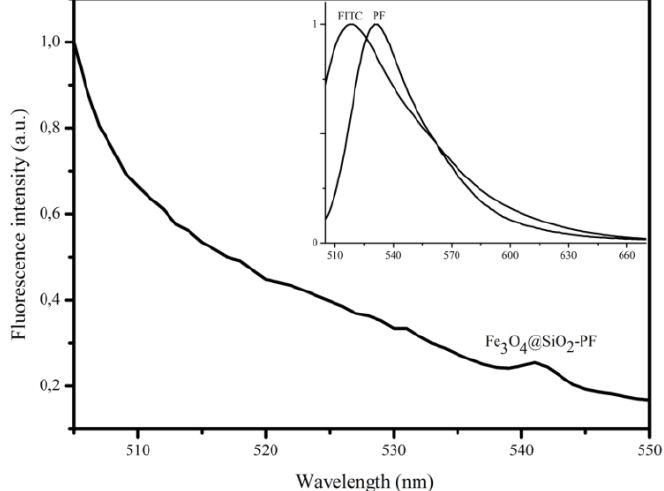
Figure 7. Normalized fluorescence spectra of FITC, PEI conjugated with FITC (PF)